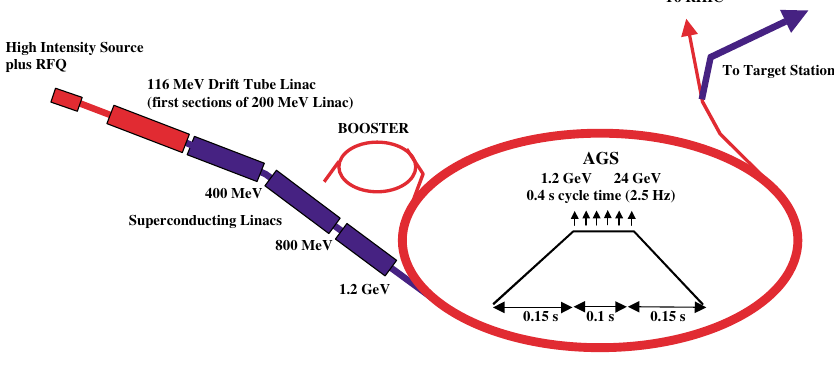
FIG. 12. (Color) AGS proton driver layout.